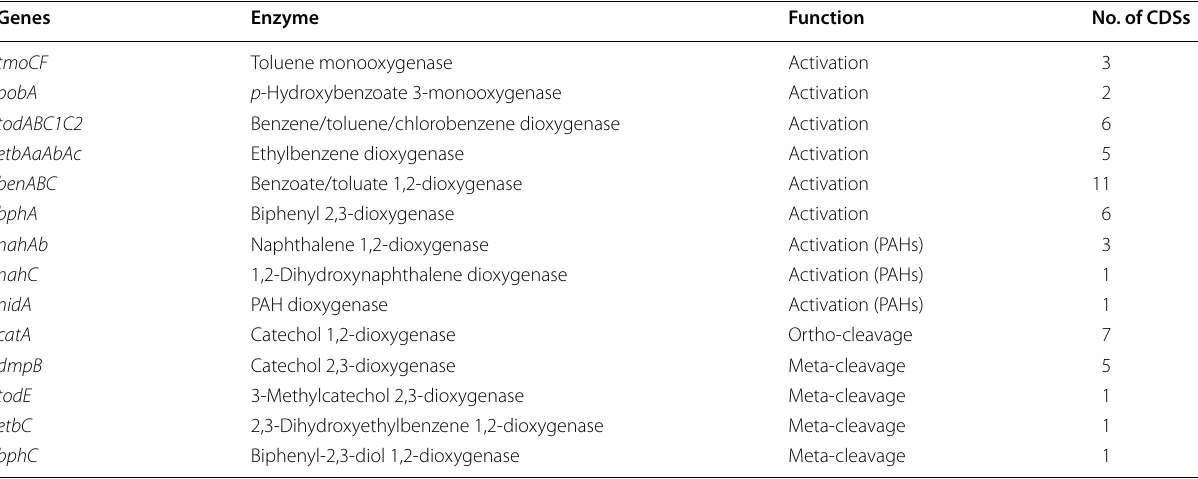
Table 1 Key monooxygenases and dioxygenases involved in the activation and ring cleavage of aromatic hydrocarbons in the diesel- degrading